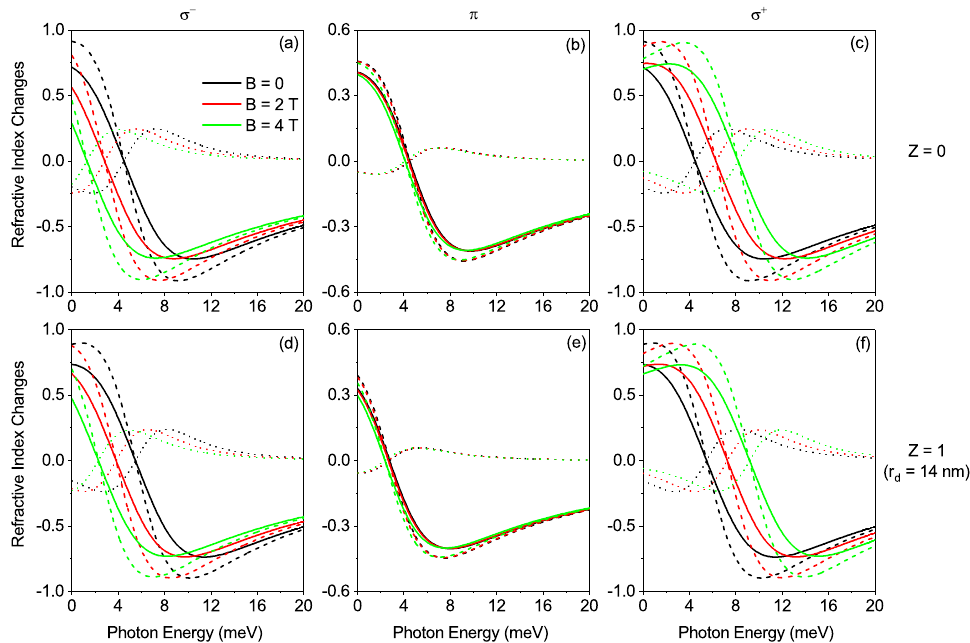
Figure 5. Plot of refractive index changes as a function of the photon energy for fixed values of σ ± ( Z = 0 ) , σ ± ( Z = 1 ) , π ( Z = 0 ) and π ( Z = 1 ) transitions and varying MF ( a – f ). The dashed, doted and solid curves account for linear, third-order nonlinear and total refractive index changes